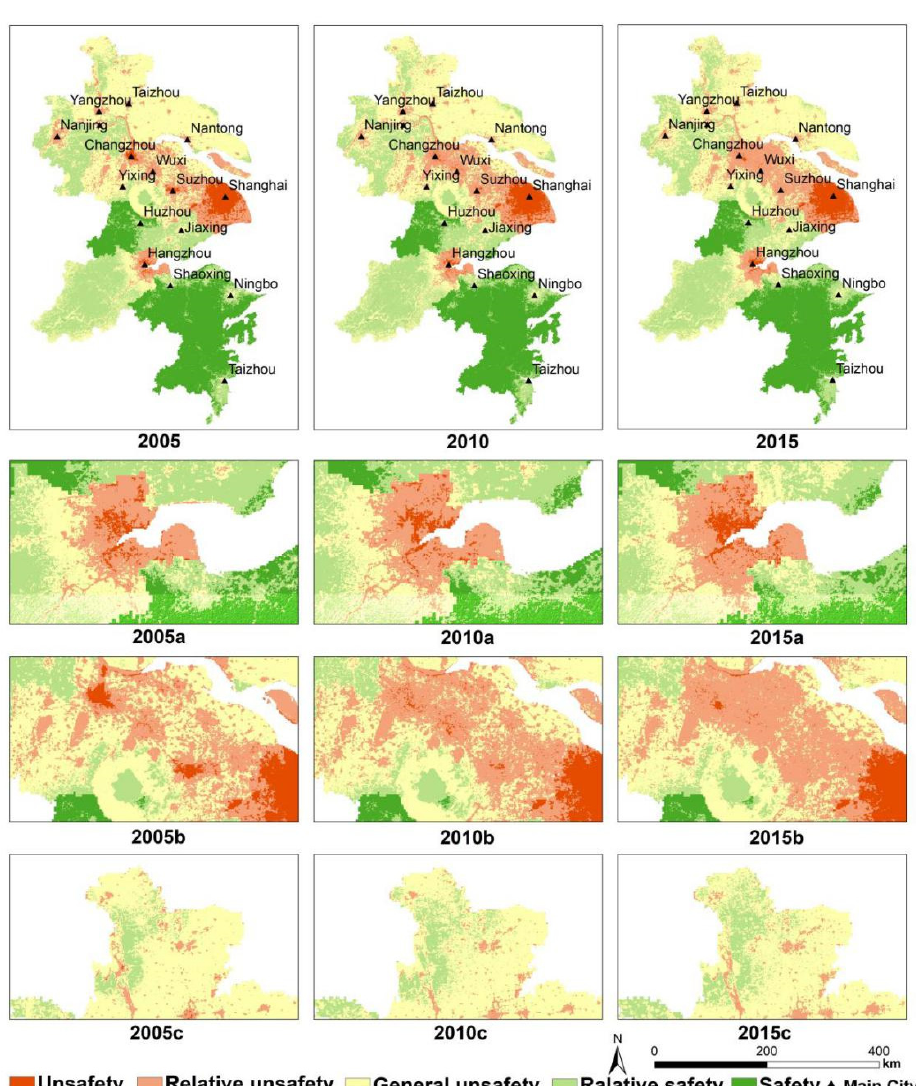
Figure 6. The ES pattern of the YRD in 2005, 2010, and 2015 (where a , b , and c represent their respective regions, respectively; 2005a, 2010a, and 2015a represent the ES pattern of region a in 2005, 2010, and 2015, respectively. The rest are the same.).